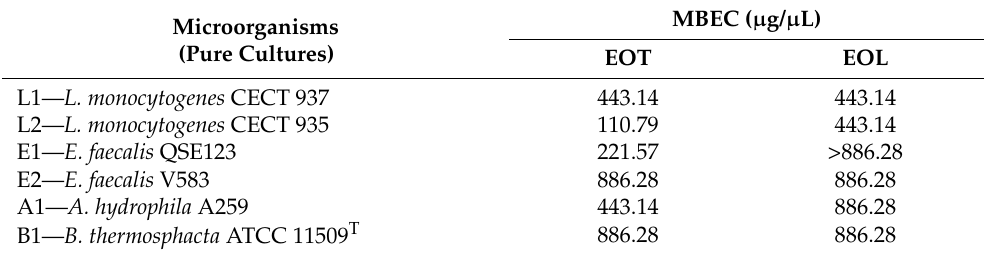
Table 7. Minimum biofilm eradication concentration (MBEC) against pure cultures.